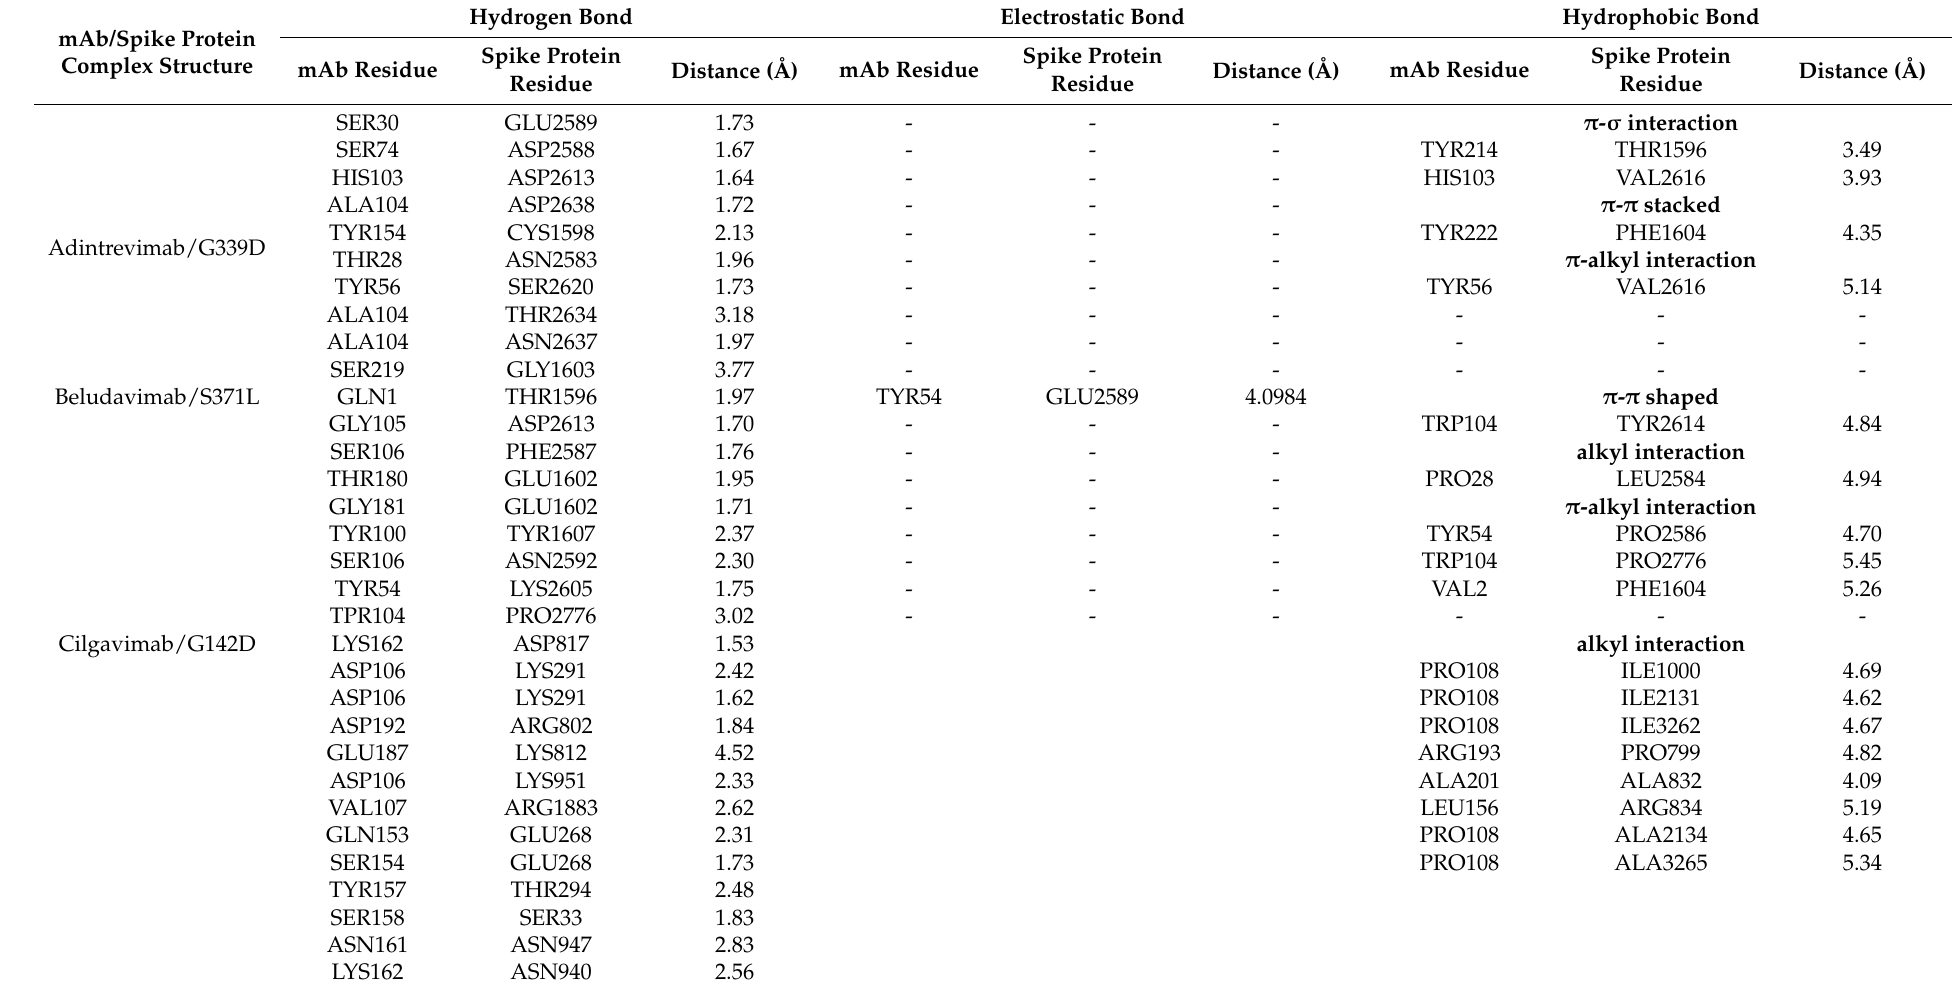
Table 2. Biomolecular interactions amongst the mutant spike proteins of Omicron variants and 5 selected efficacious mAbs. mAb/Spike